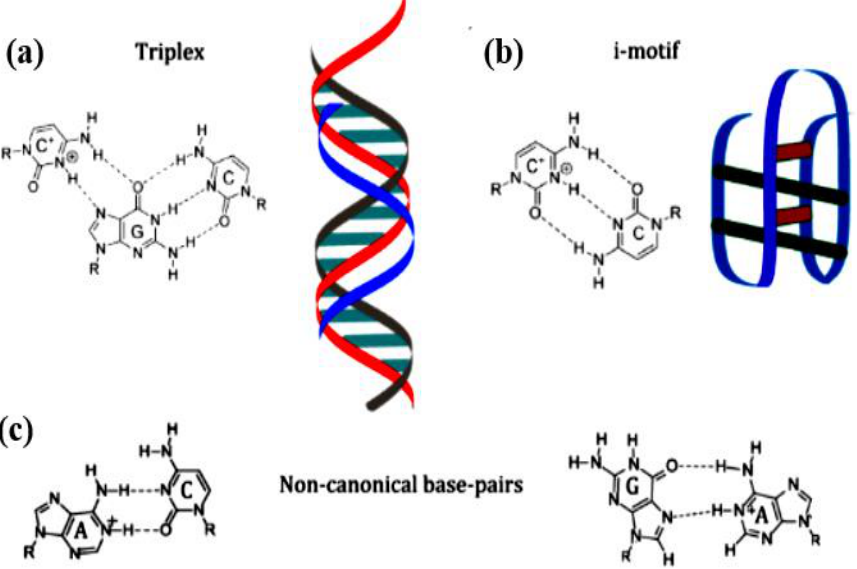
Figure 3. Nucleic acid base-pair binding and motifs that respond to pH. Illustration of the triplex binding motif and C + GC triplex non-canonical base pair binding in ( a ). Illustration of the i-motif, which is made up of C + C bonds, and non-canonical C + C base pair binding in ( b ). ( c ) Left: A non-canonical base pair binding is shown. Right: Illustration of A + G non-canonical base pair binding.